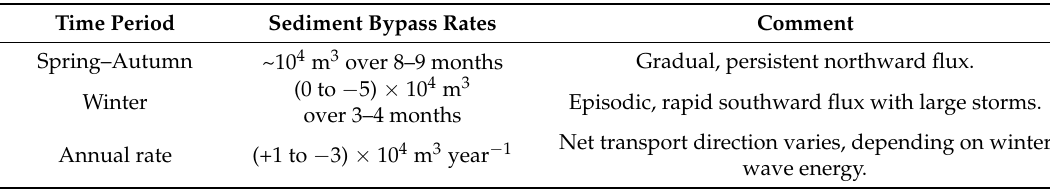
Table 5. Seasonal and annual bypassing